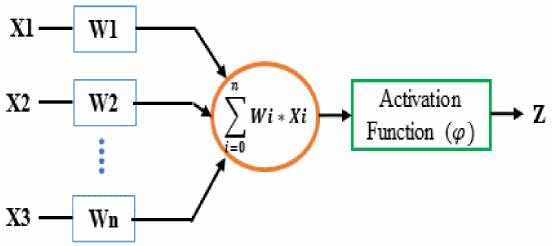
Figure 4. Basic Structure of a Neuron.